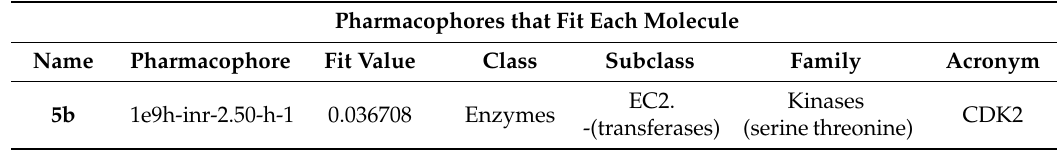
Table 2. Reverse pharmacodynamic docking results.